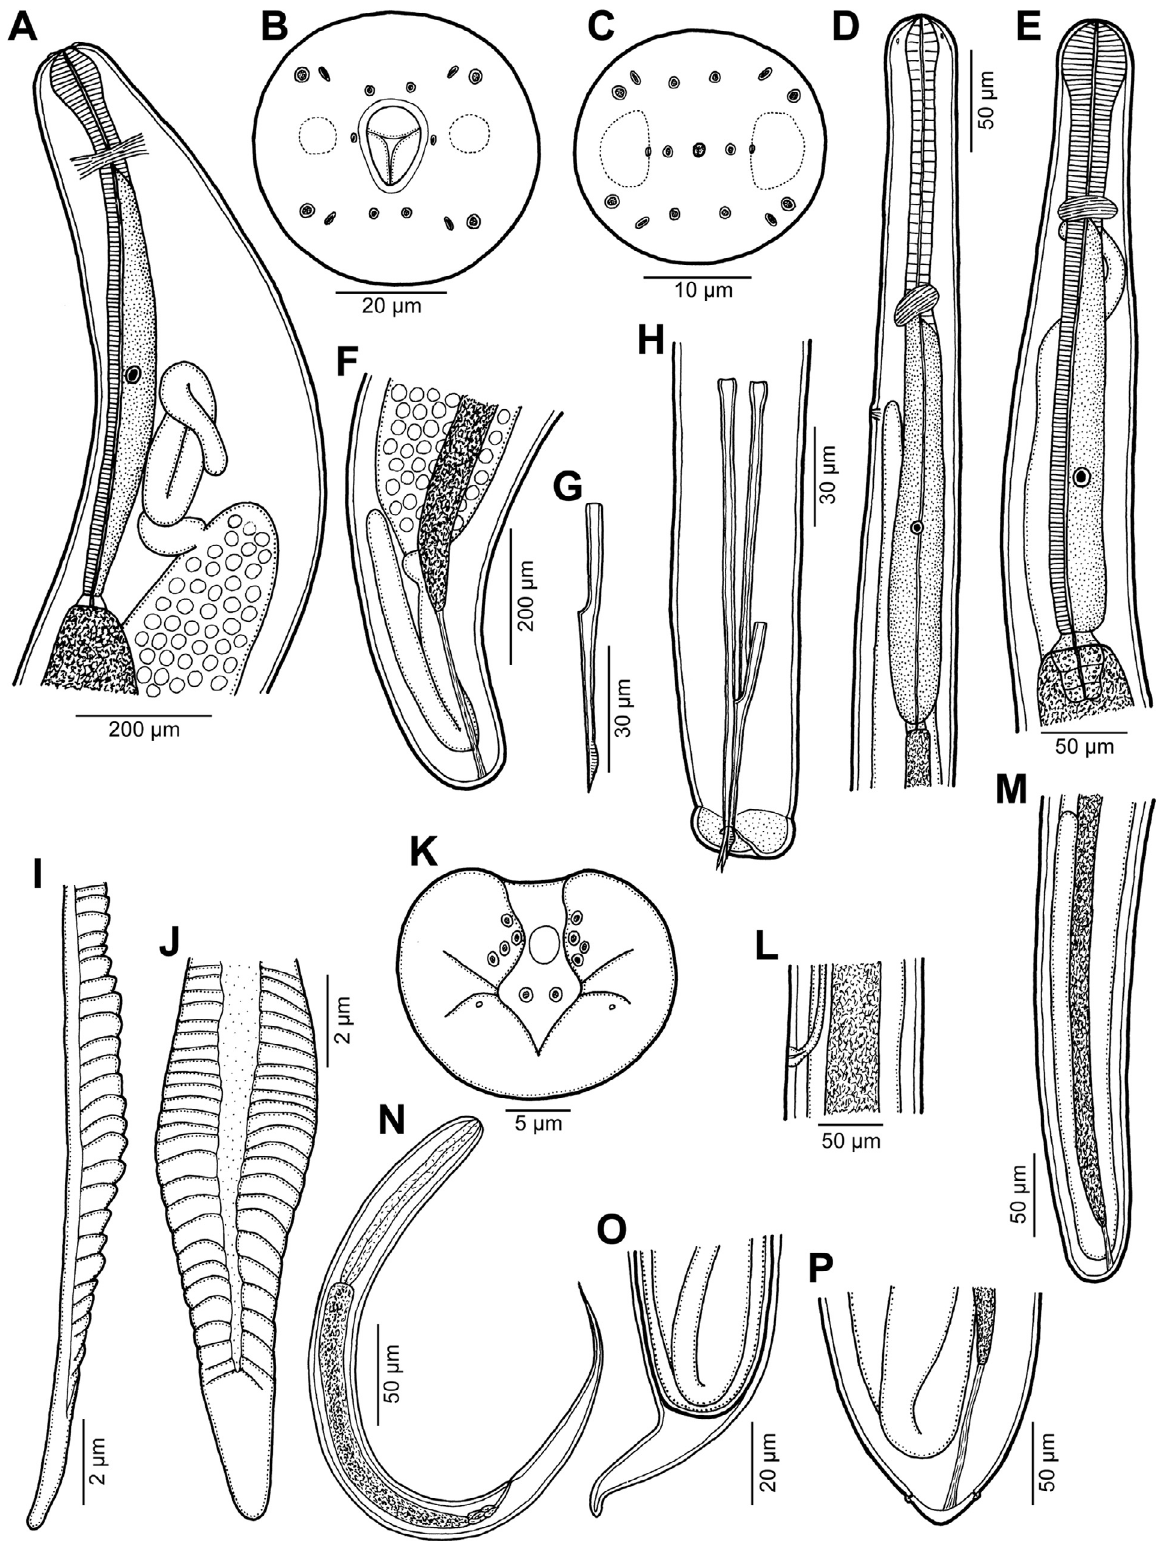
Figure 1. Philometra austropacifica n. sp. from Alepes vari . A: Anterior end of subgravid female, lateral view. B, C: Cephalic end of subgravid female and male, respectively, apical views. D: Anterior end of male, lateral view. E: Anterior end of mature female, lateral view. F: Posterior end of subgravid female, lateral view. G: Gubernaculum, lateral view. H: Posterior end of male, sublateral view. I, J: Distal end of gubernaculum, lateral and dorsal views. K: Caudal end of male, apical view. L: Vulva of mature female, lateral view. M: Posterior end of mature female, lateral view. N: Larva from uterus, lateral view. O: Caudal end of fourth-stage larva undergoing last moult. P: Caudal end of very small subgravid female, dorsoventral